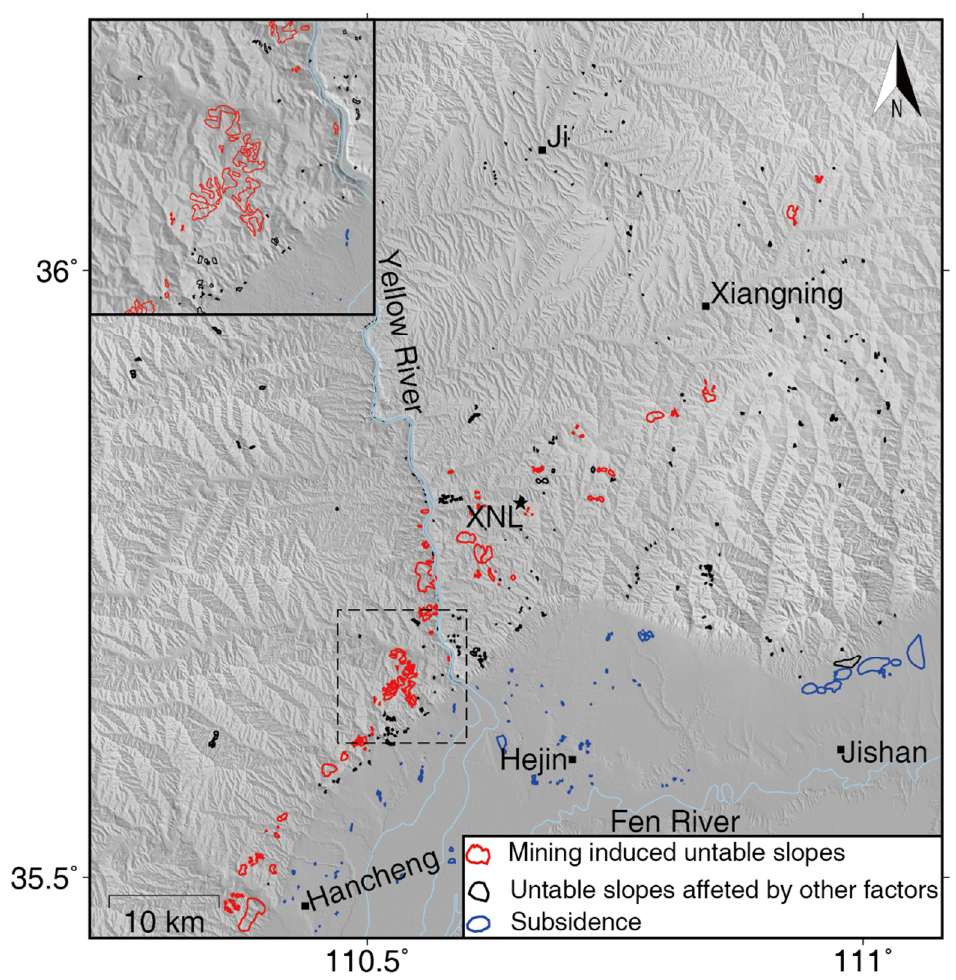
Figure 6. Detected unstable areas within the study area. The background is the hill-shaded Digital Elevation Model (DEM).